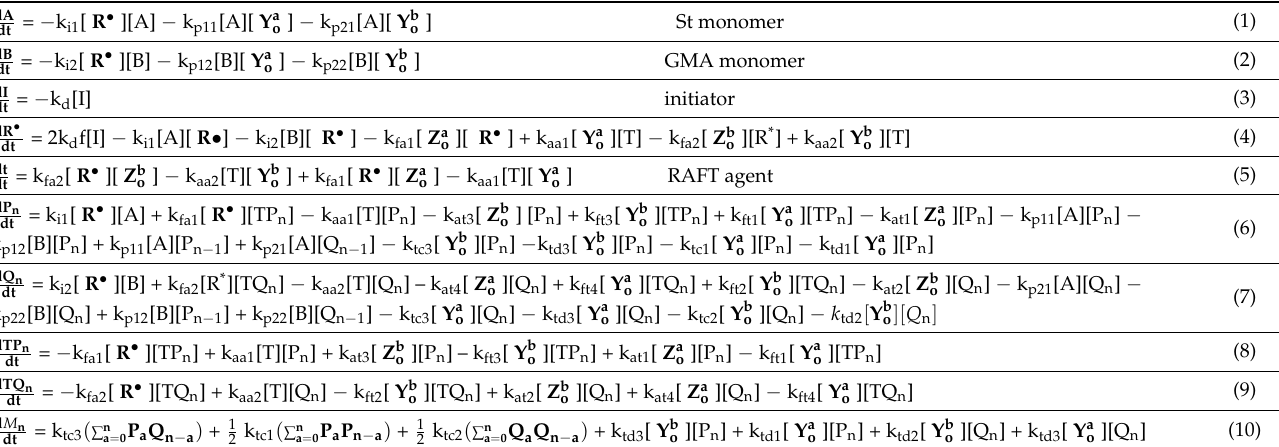
Table 3. Kinetic equation for